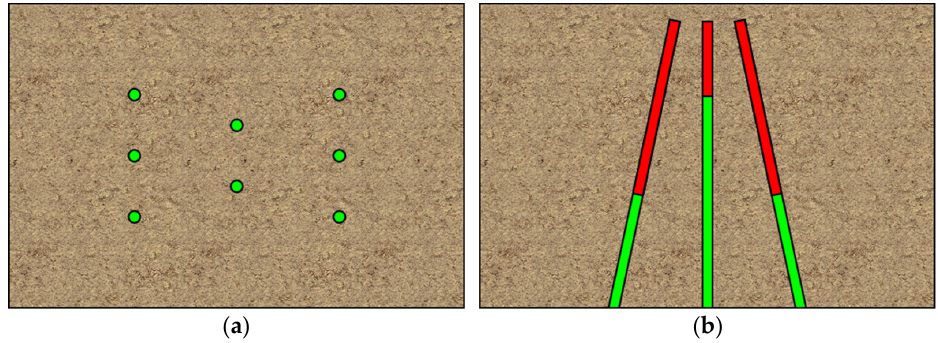
Figure 2. Hole layout of the improved wedge cutting method: ( a ) front view and ( b ) top view.